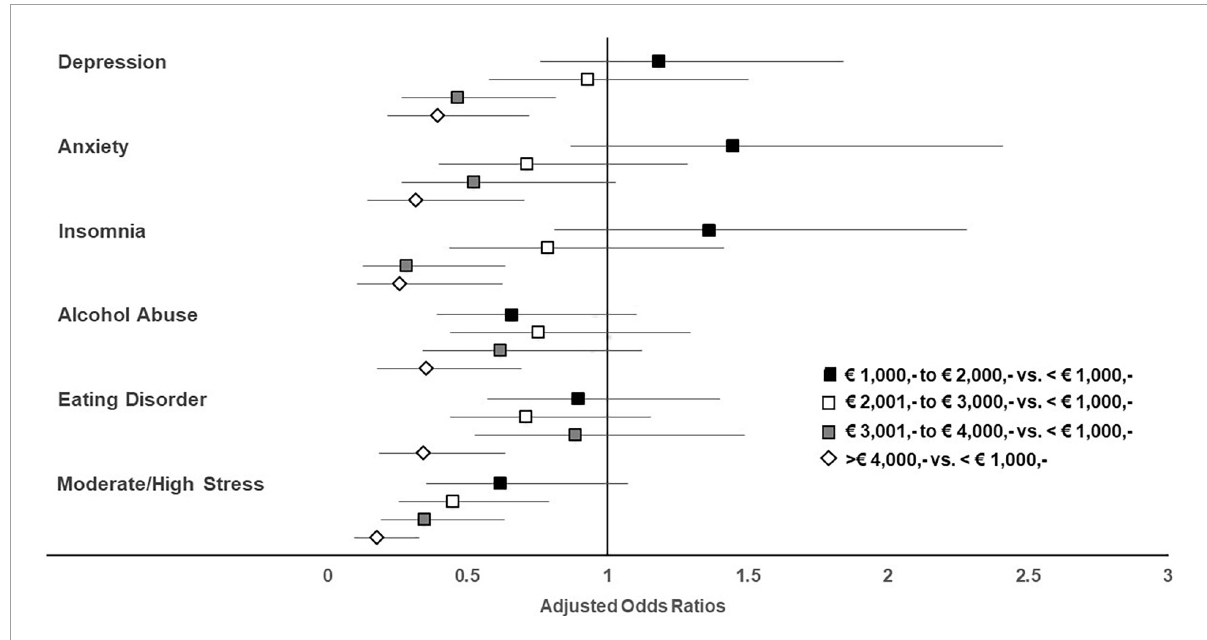
FIGURE3 Adjusted odds ratios stratified by income with the category “ < € 1,000,-” being the